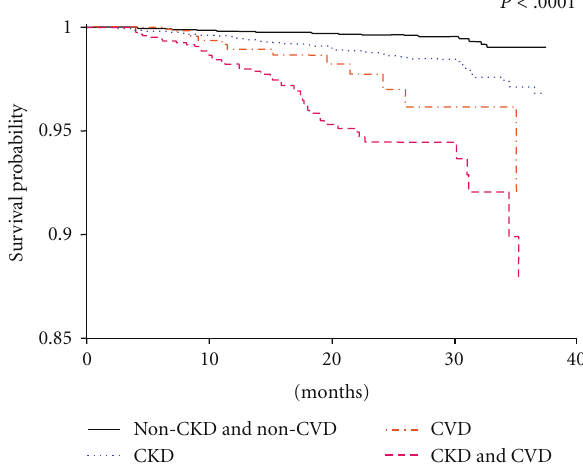
Figure 3: Kapla-Meier curves for all-cause mortality stratified by no chronic kidney disease (CKD)/no cardiovascular disease (CVD), prevalent CKD, CVD, and CVD + CKD from the KEEP Program